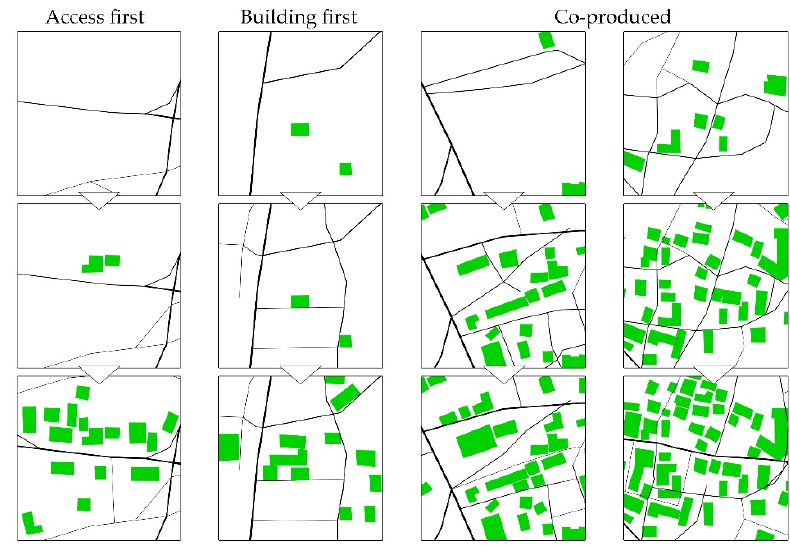
Figure 6. The relations between the emerging access network and